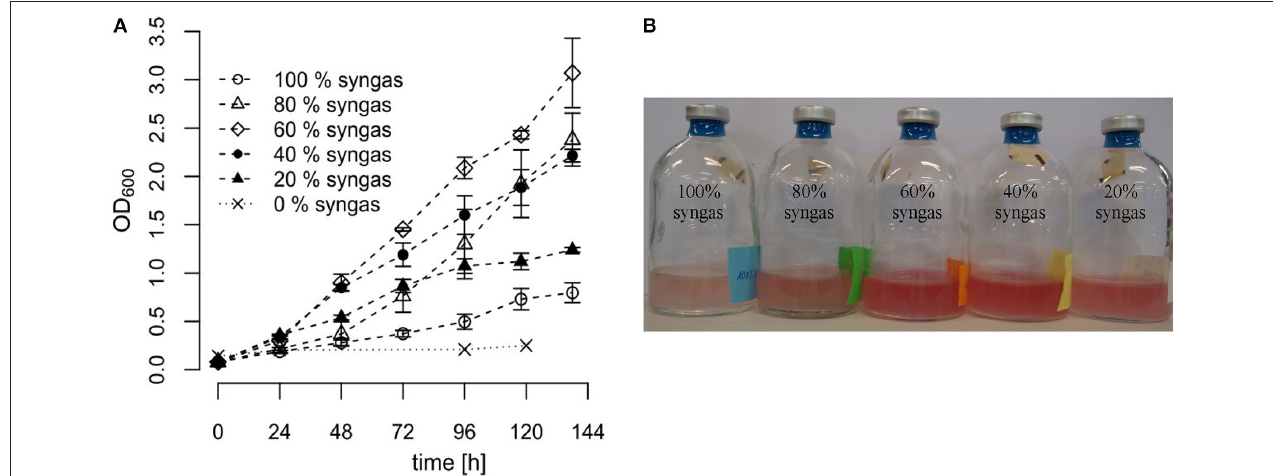
FIGURE 2 | Growth of R. rubrum in serum vials with different syngas concentrations. R. rubrum cultures were grown on modified RRNCO medium containing 0.59g L − 1 acetate and the indicated syngas concentration in the headspace. The headspace filled with 100% syngas contained 40% CO, 40% H 2 , 10% CO 2 , and 10% N 2 v/v. The other samples were diluted with N 2 as indicated. (A) Growth curves are based on OD 600 measurements. The error bars indicate the mean ± standard deviation determined from three independent replicates. (B) The R. rubrum culture in serum vials after 96h of incubation. The 0% syngas control sample was